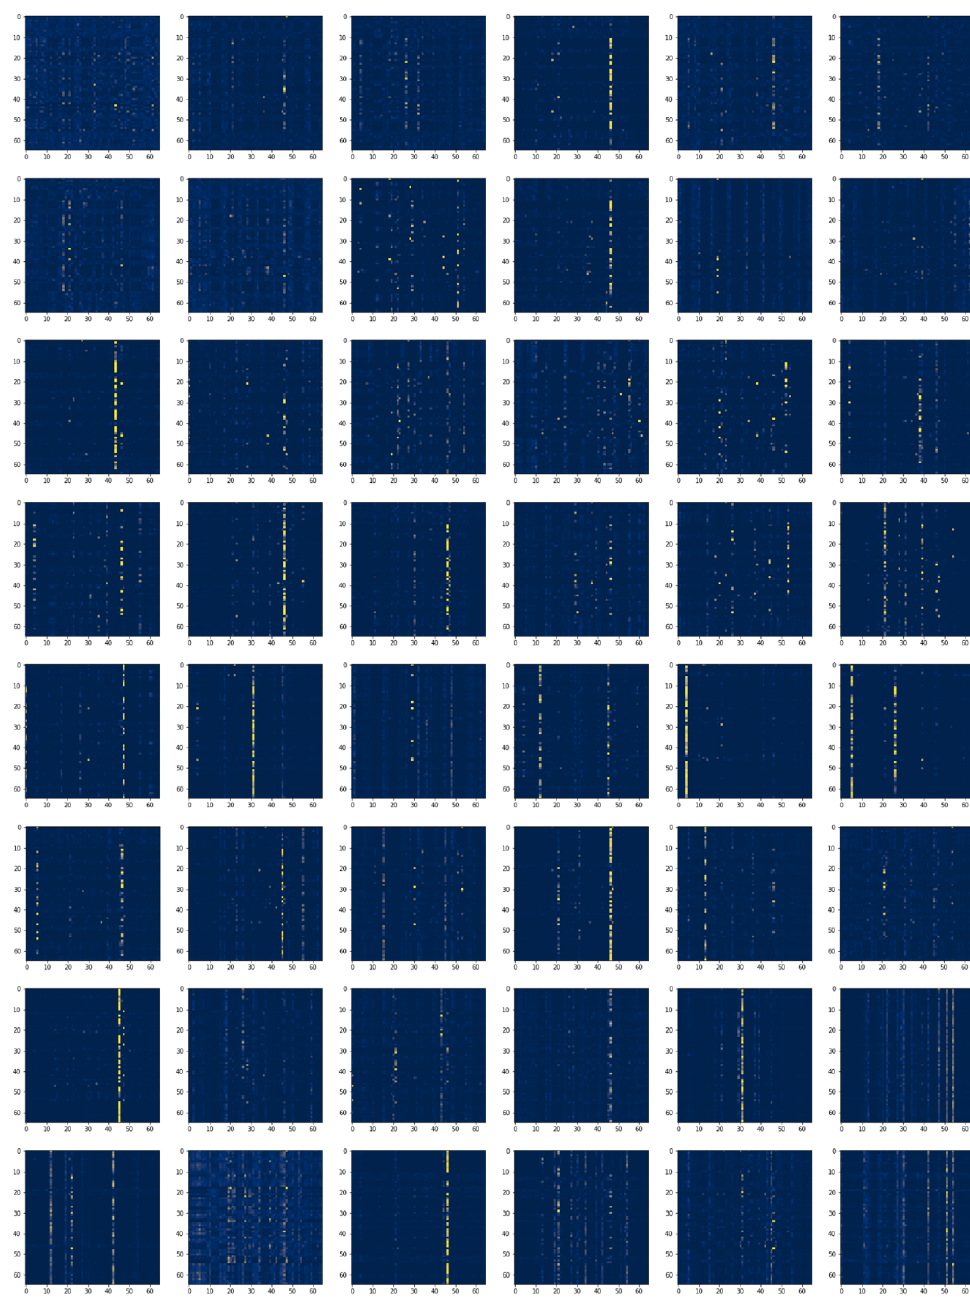
Figure A2. The attention maps for a random AD structural MRI slice from the testing set in AD vs. HC vs. MCI in OViTAD with head = 8 and depth = 6, input dimension =